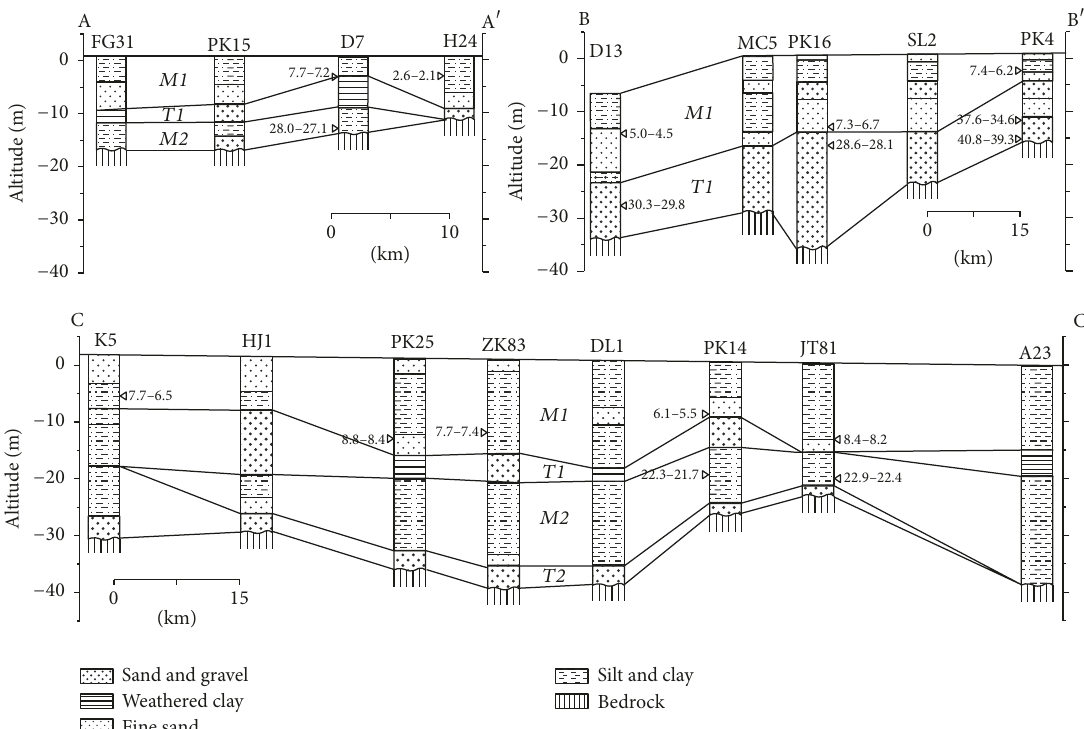
Figure 2: Cross sections in the PRD (from Zong et al.